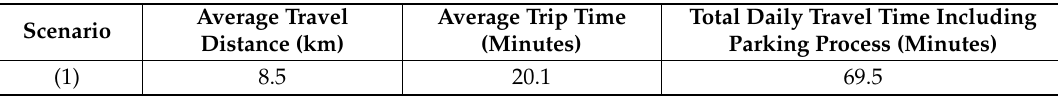
Table 2. Trip mobility indicators of travelers for the base scenario.